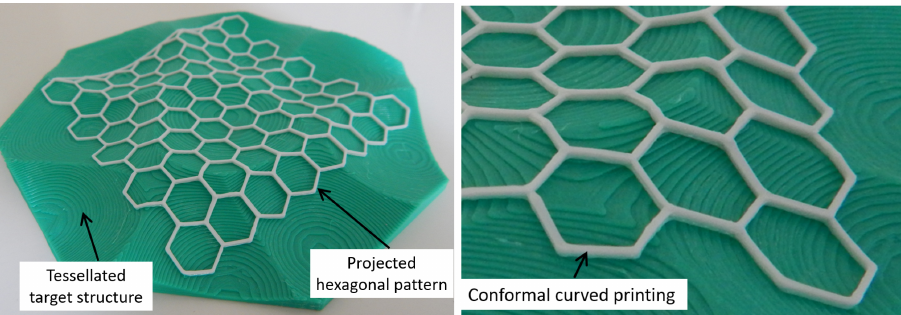
Figure 17. Simulation of a hexagonal pattern projected on an arbitrary tessellated target structure.